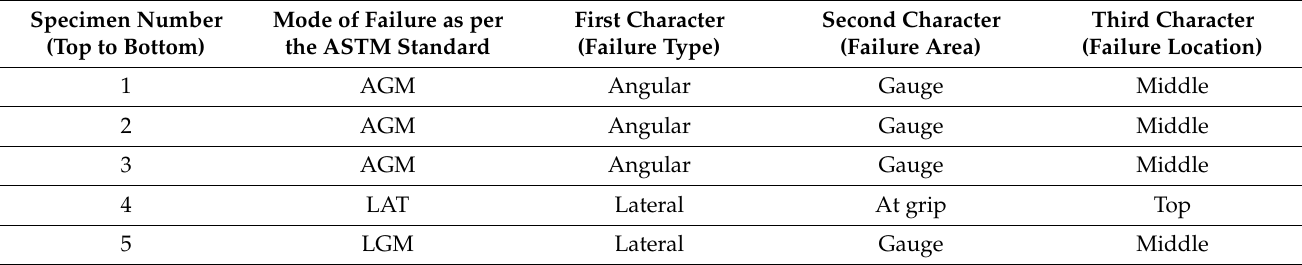
Table 6. Modes of failure—carbonised eggshell filled composite specimens.